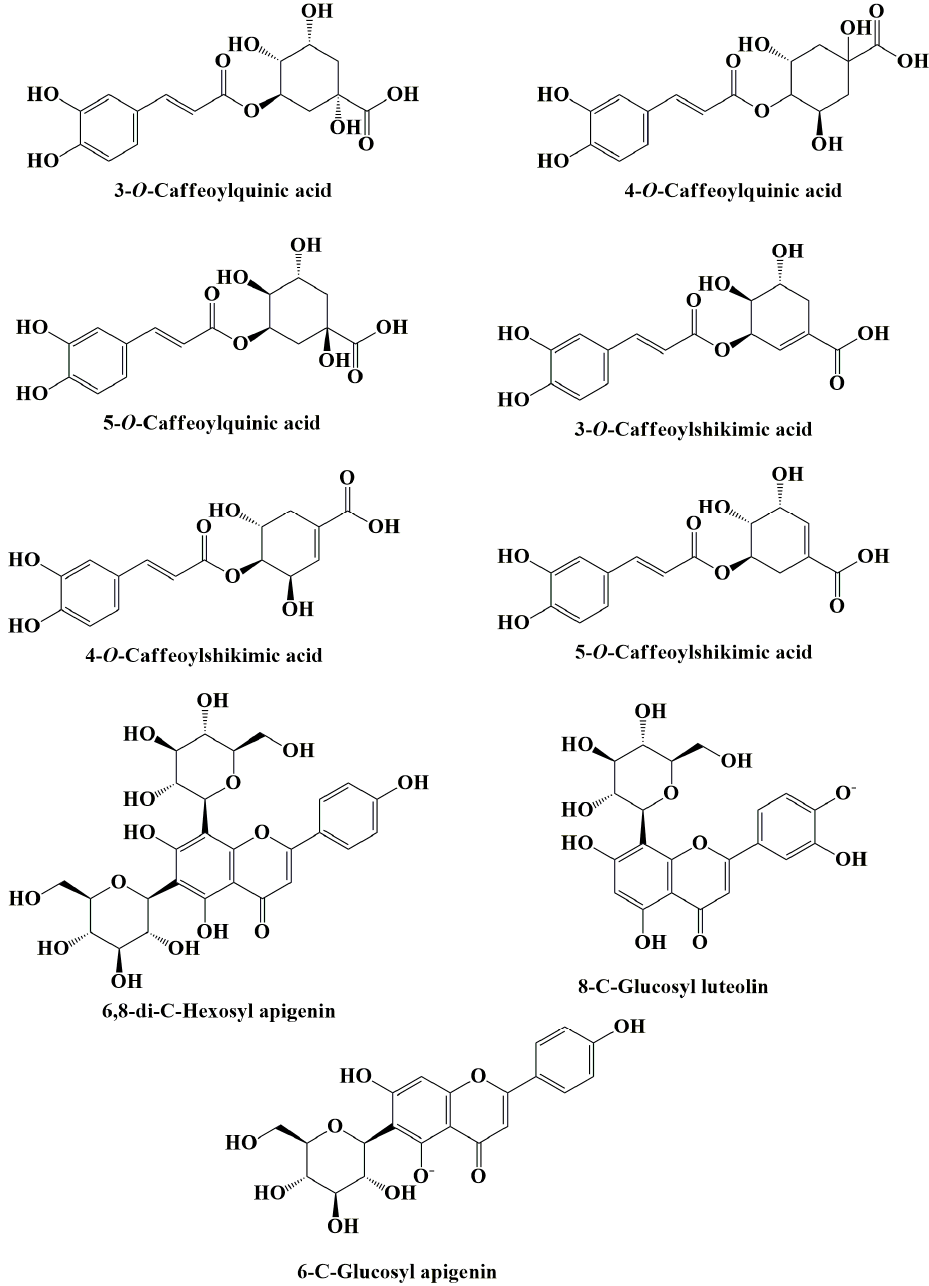
Figure 6. Major phytochemical compounds present in açaí leaves and roots.